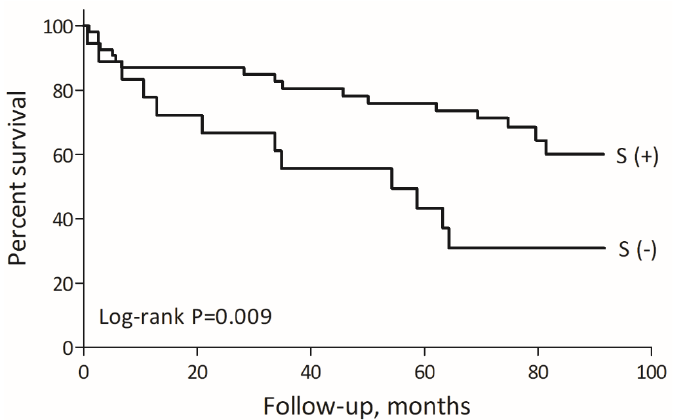
Figure 3. The long-term mortality in MINOCA patients treated with vs. without statins. Abbreviations: S: statin.